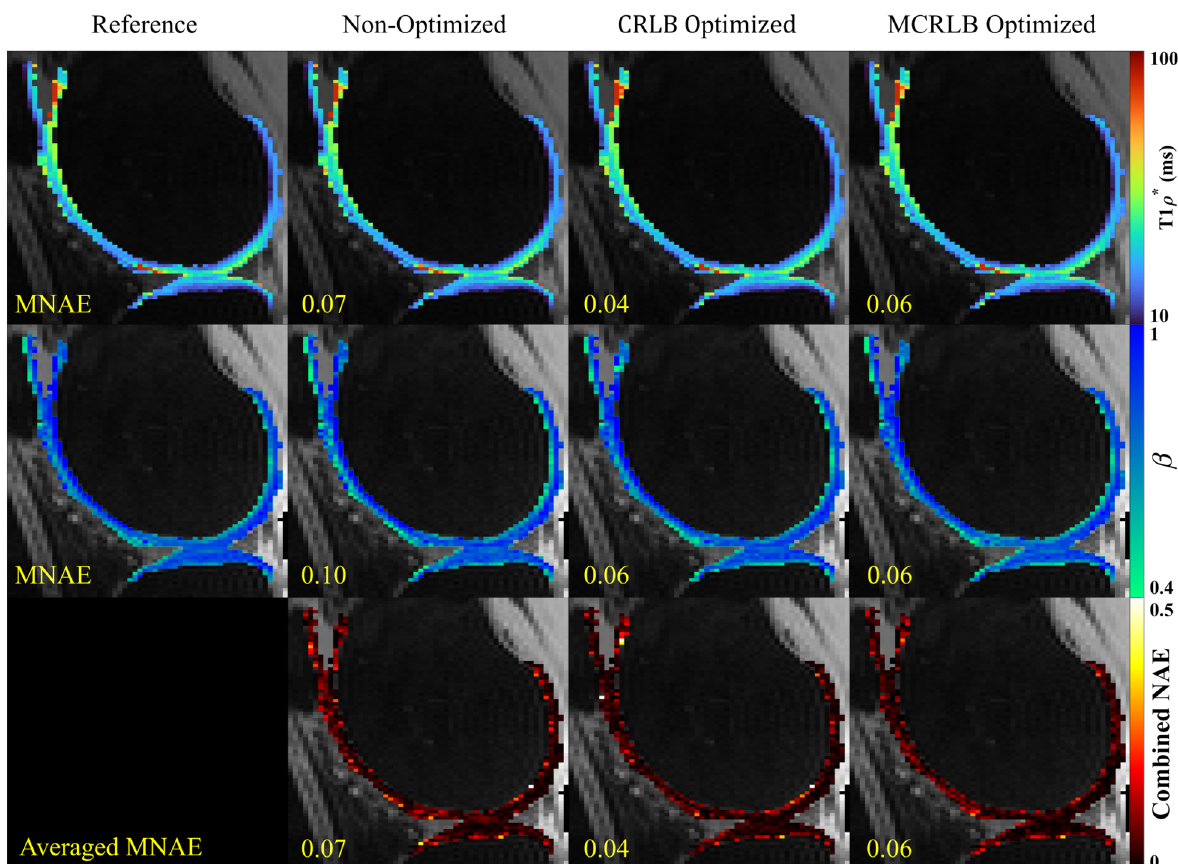
Figure 6. Parameter maps for the stretched-exponential model were fitted using the three different sampling schedules on the first volunteer dataset. The maps look very similar, but the combined NAE maps highlight the differences between them. Image created using Matlab 27 and Inkscape 28 .